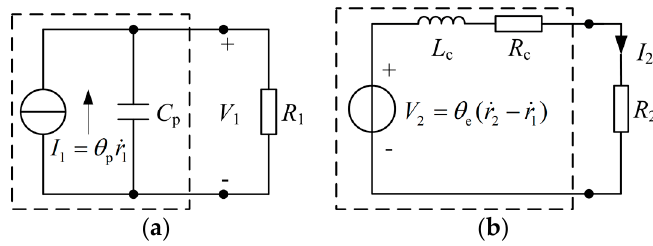
Figure 3. Equivalent circuits. ( a ) The piezoelectric energy harvester (PEH) subsystem; ( b ) The electromagnetic energy harvester (EMEH) subsystem.